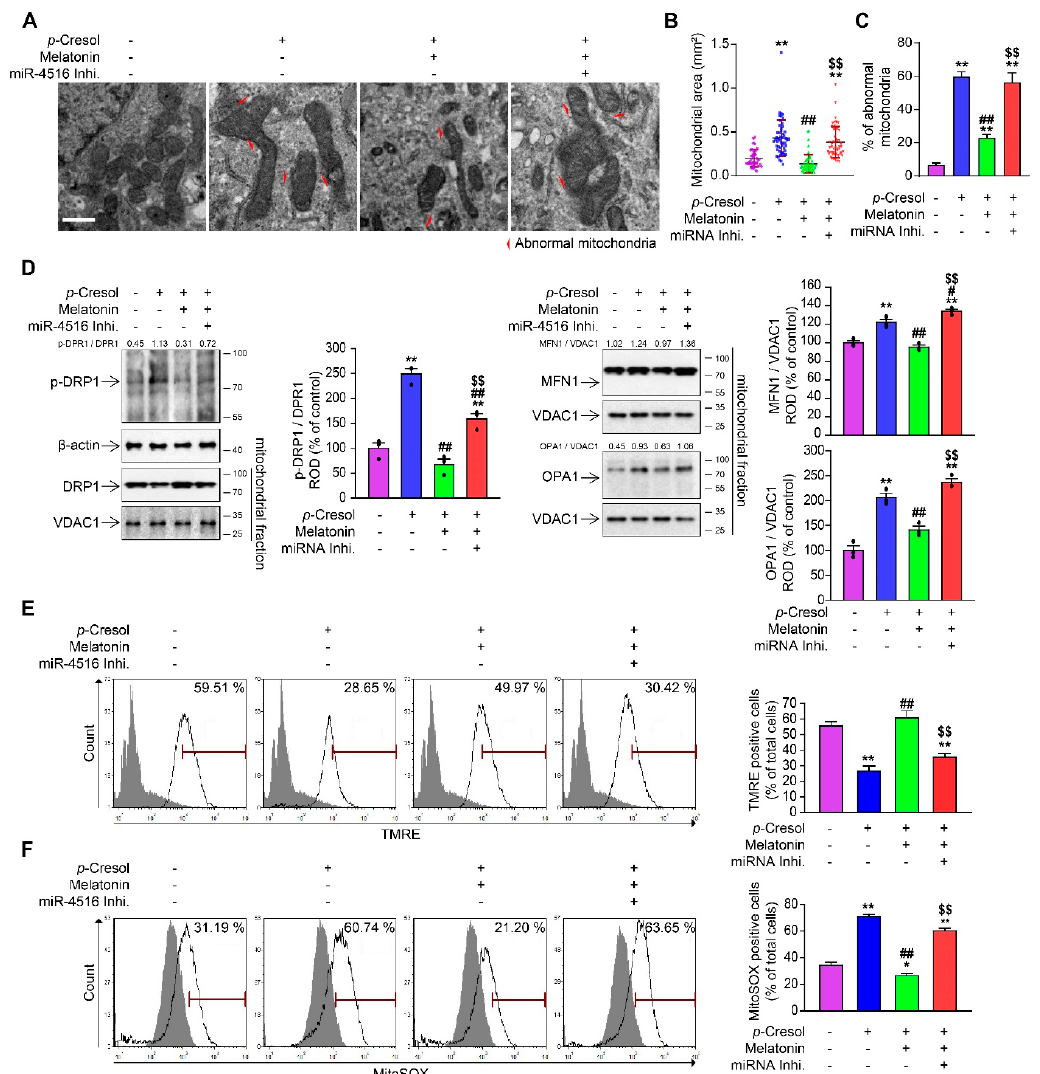
Figure 3. Melatonin-induced miR-4516 rescues abnormal mitochondrial functions. ( A ) Representative TEM images for TH1 cells either treated with p -Cresol alone, melatonin under p -Cresol exposure, or miR-4516 inhibitor (50 nM for 48 h) before melatonin treatment, compared with TH1 control (scare bar = 1 μ m). ( B , C ) Measurement of mitochondrial area and number of abnormal mitochondria in each experimental group (n = 3). ( D ) The effects of melatonin on p-DRP1, DRP1, MFN1, and OPA1 were reversed with miR-4516 inhibitor. Protein expression level was detected using western blot, quantified by densitometry, and normalized to DRP1 or VDAC1 levels (n = 3) respectively. ( E , F ) Measurement of TMRE ( E ) and MitoSOX ( F ) positive cells for each group (n = 3). The values represent mean ± SEM, * p < 0.05, ** p < 0.01 versus control; # p < 0.05, ## p < 0.01 versus p -Cresol exposure; $$ p < 0.01 versus melatonin-treated cells in p -Cresol exposure. The β -actin or VDAC1 was used as Western blot loading control for whole cell lysates or mitochondrial fraction, respectively.